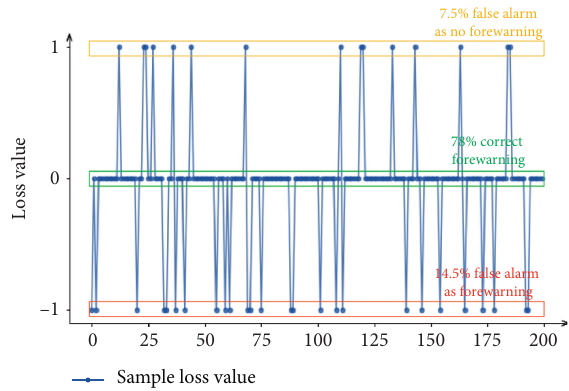
Figure 20: Analysis diagram of sample loss value of driving risk prediction model.